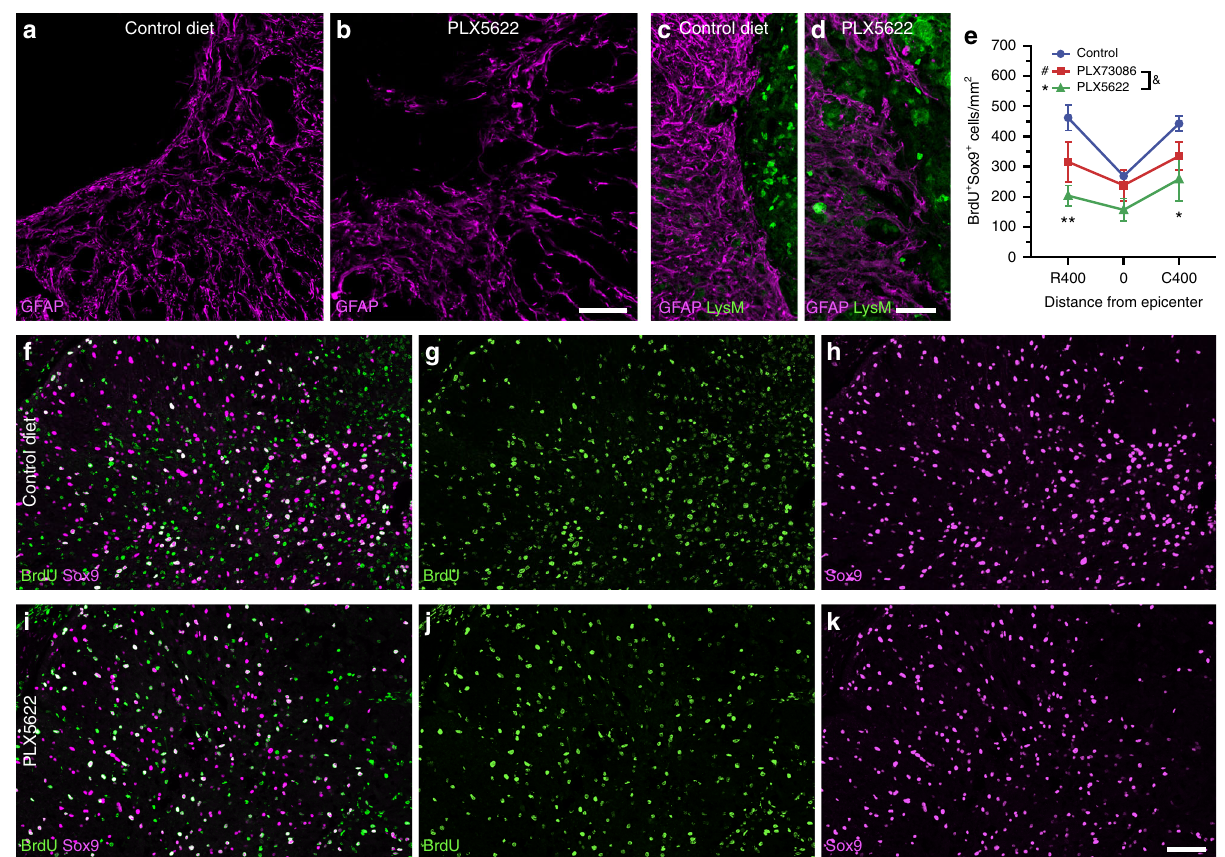
Fig. 6 The elimination of microglia results in a reduced proliferation of astrocytes and disorganized astrocytic scar at the lesion border. a – d Confocal immuno fl uorescence microscopy of astrocytes (GFAP, purple) in spinal cord sections taken at the lesion epicenter in Cx3cr1 creER :: R26-TdT :: LysM -eGFP mice at 14 days post-injury (dpi). In mice fed with the control diet ( a , c ), astrocytes adjacent to the site of SCI exhibit elongated processes oriented parallel to the lesion border, thus forming a compact scar. This astrocytic response was compromised in mice depleted of microglia using PLX5622 ( b , d ), and associated with clusters of blood-derived myeloid cells (LysM-eGFP + , green cells in d ) spreading outside of the lesion core. e Total counts of Sox9 + BrdU + cells at the epicenter and both rostral (R) and caudal (C) to the lesion at 7 dpi in mice fed the control diet (blue), PLX73086 (red) or PLX5622 (green) ( n = 4 mice per group). f – k Representative confocal images showing the proliferation of astrocytes (Sox9 + , purple cells), as demonstrated by their incorporation of BrdU (green cells), in mice treated with PLX5622 ( f – h ) or the control diet ( i – k ) and killed at 7 dpi. Data are expressed as mean ± SEM. * p < 0.05, ** p < 0.01, PLX5622 versus the control group. Statistical analysis was performed using a two-way ANOVA followed by a Bonferroni ’ s post hoc test. Scale bars: ( a and b , in b ) 50 µ m, ( c and d , in d ) 50 µ m, ( f – k , in k ) 50 µ